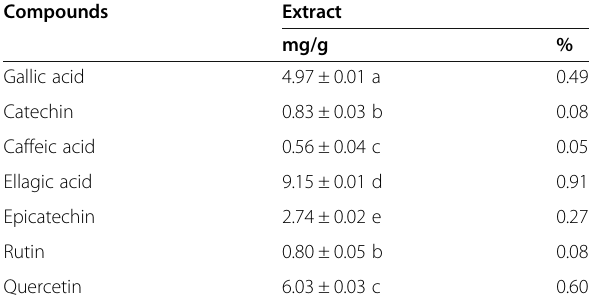
Table 4 Composition of Terminalia chebula fruit